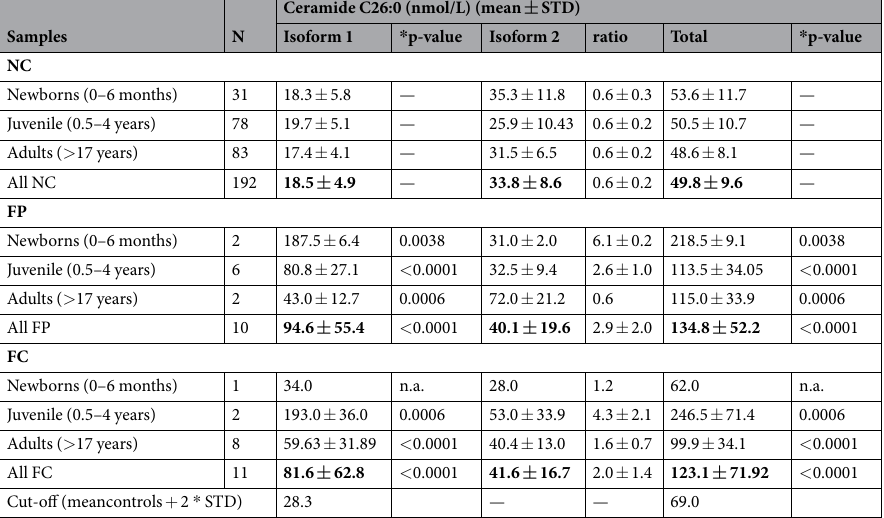
— — 69.0 Table 2. Concentration of total C26:0 ceramide and its isoforms in the blood of NC, FP and FC. The values are shown as mean ± standard deviation. * p-value found in Mann-Whitney test for FP vs. NC of the same category. NC = normal controls, FP = Farber patients, FC = Farber